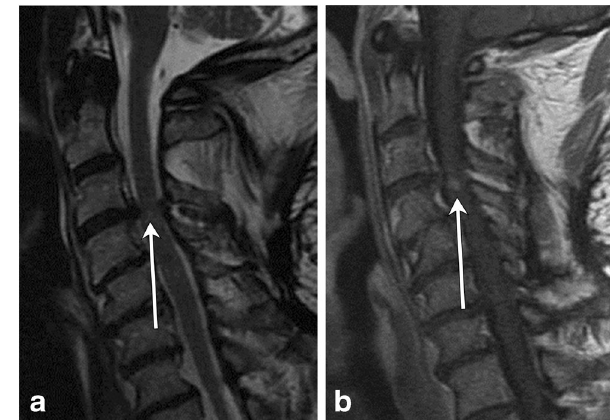
Fig. 23 Compressive myelopathy. A 50-year-old patient with bilateral hand tingling. a Sagittal T2 image shows severe spinal canal narrowing at C3 – C4 due to degenerative changes, with focal faint signal hyperintensity (arrow). b Post-contrast image shows focal enhancement